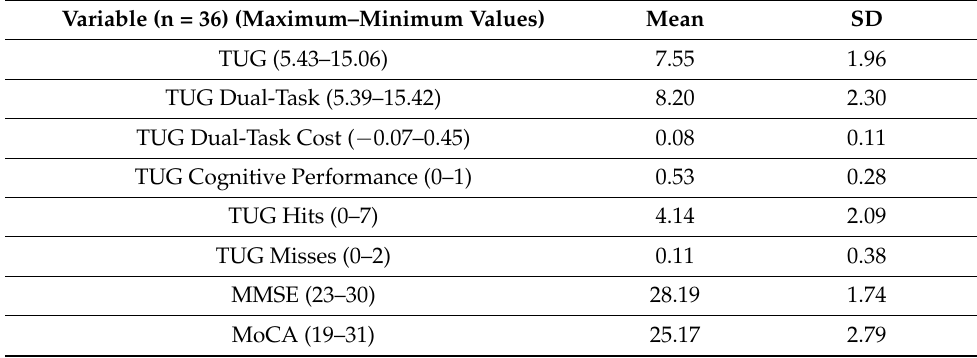
Table 2. Performance on the TUG test, dual-task TUG test, and cognitive tests (MMSE and MoCA).